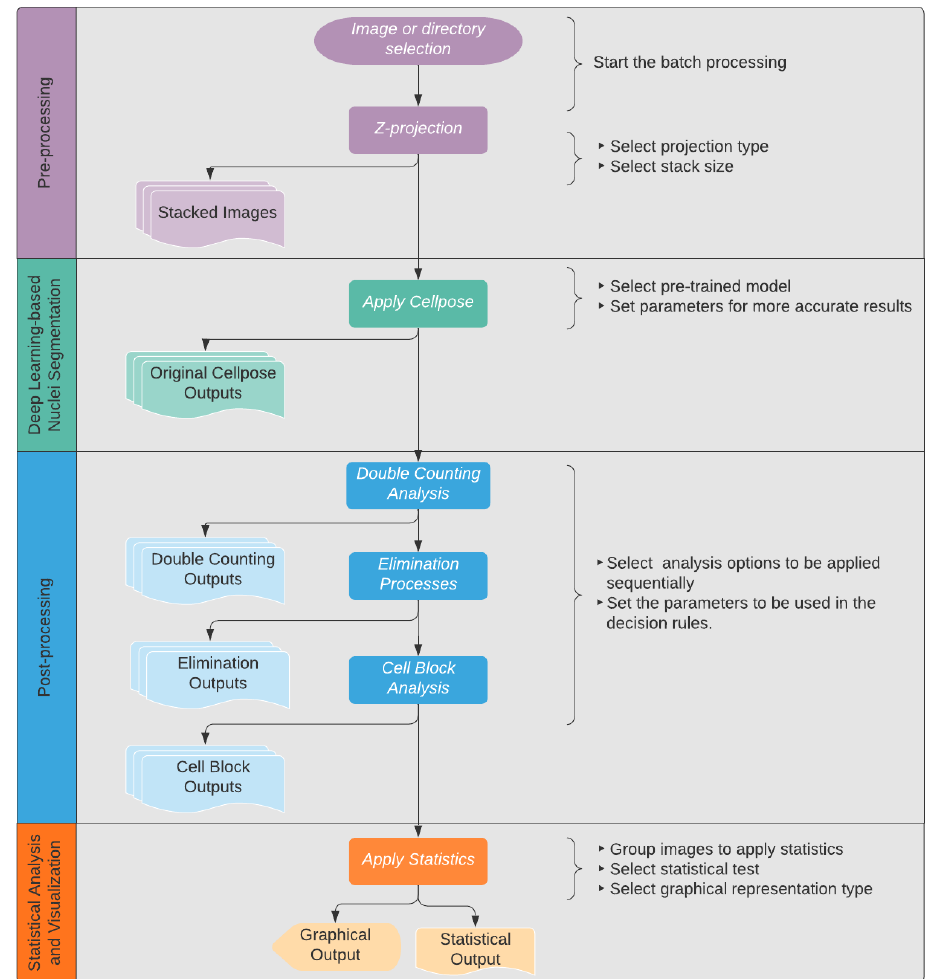
Figure 5. Overall flowchart representing the image analysis pipeline implemented in Deetect. The first section (pre-processing) includes batch processing and Z-projection. The outputs of this section are partially stacked images used directly as input for Cellpose. The second section is the main segmentation process performed via Cellpose. The outputs of Cellpose are a mask list that contains all detected cell nuclei and images with an outlining of the detected cell nuclei. The third section (post-processing) contains different subprocesses to achieve more accurate results. The outputs contain a color-coded graphical output and a section for statistical